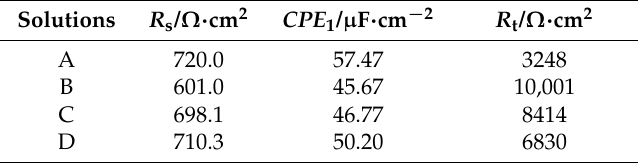
Figure 10. Electrical equivalent circuit diagrams to fit the obtained impedance spectra in Figure 9. Table 3. The parameters of the equivalent circuit for Ni ‐ P coatings in different solutions.